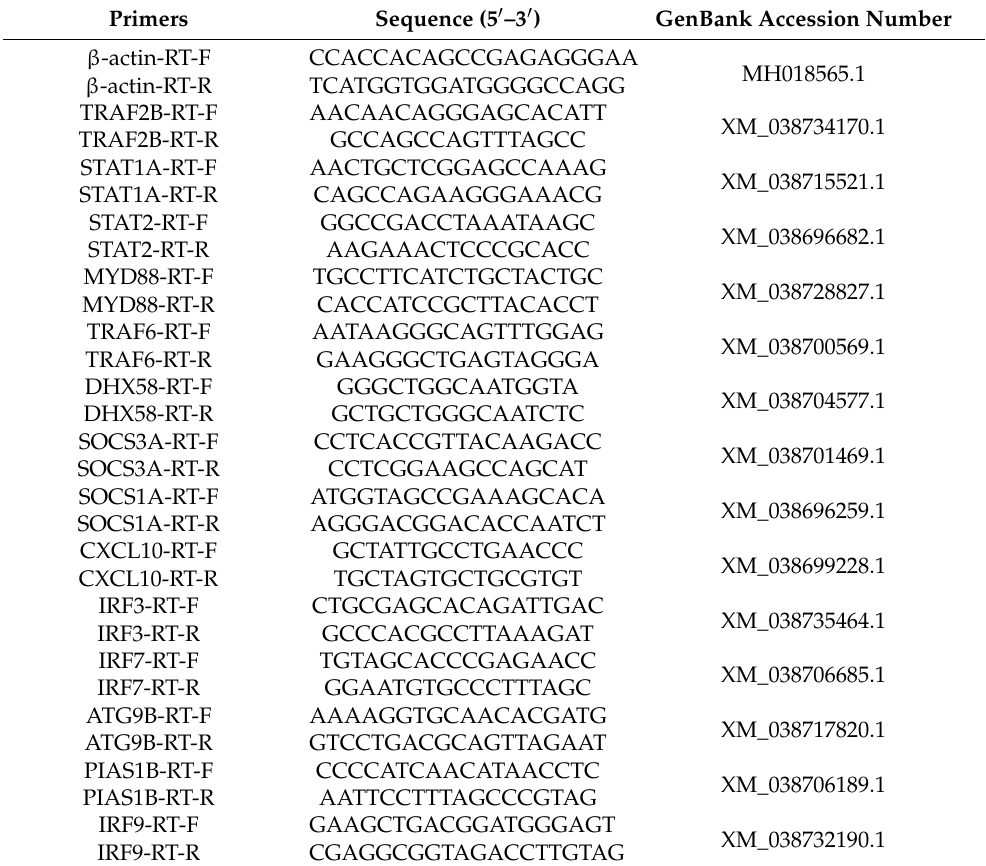
Table 1. Target gene primers used in quantitative real-time PCR